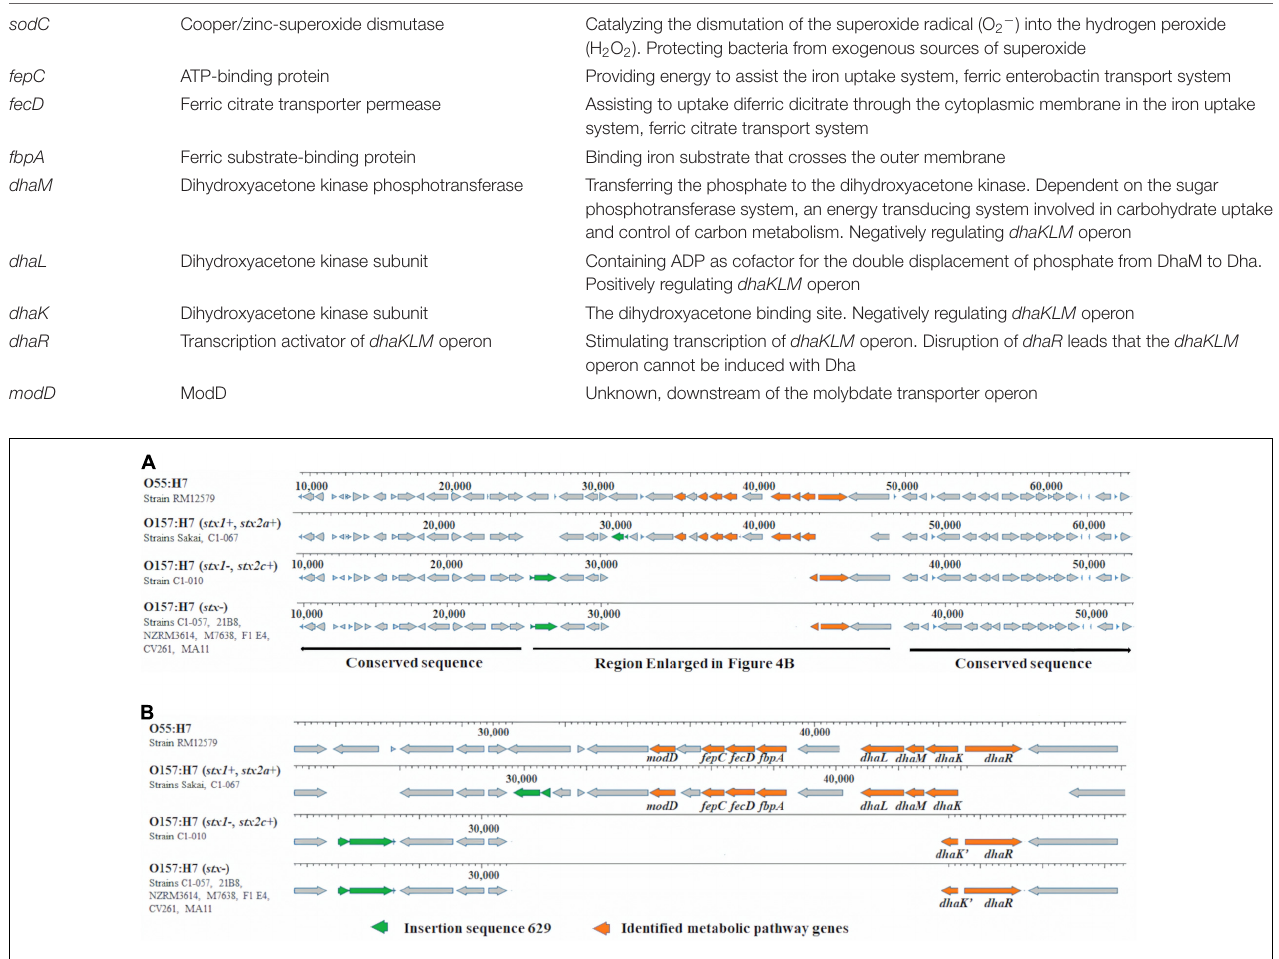
TABLE 5 | The unique genes involved in metabolic pathways harbored in two stx2a -carrying, one stx2c -carrying, and seven stx -negative Escherichia coli O157:H7 strains used in this study. Gene symbol Protein